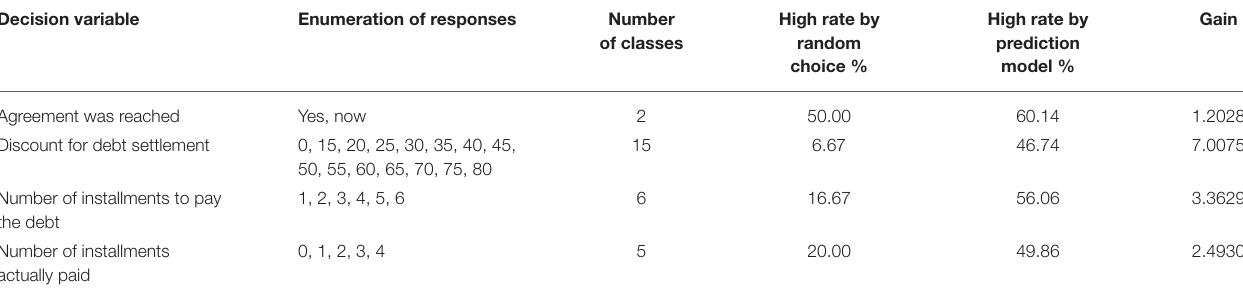
TABLE 7 | Results for predicting decisions of a debtor according to profiling through mental functioning patterns.